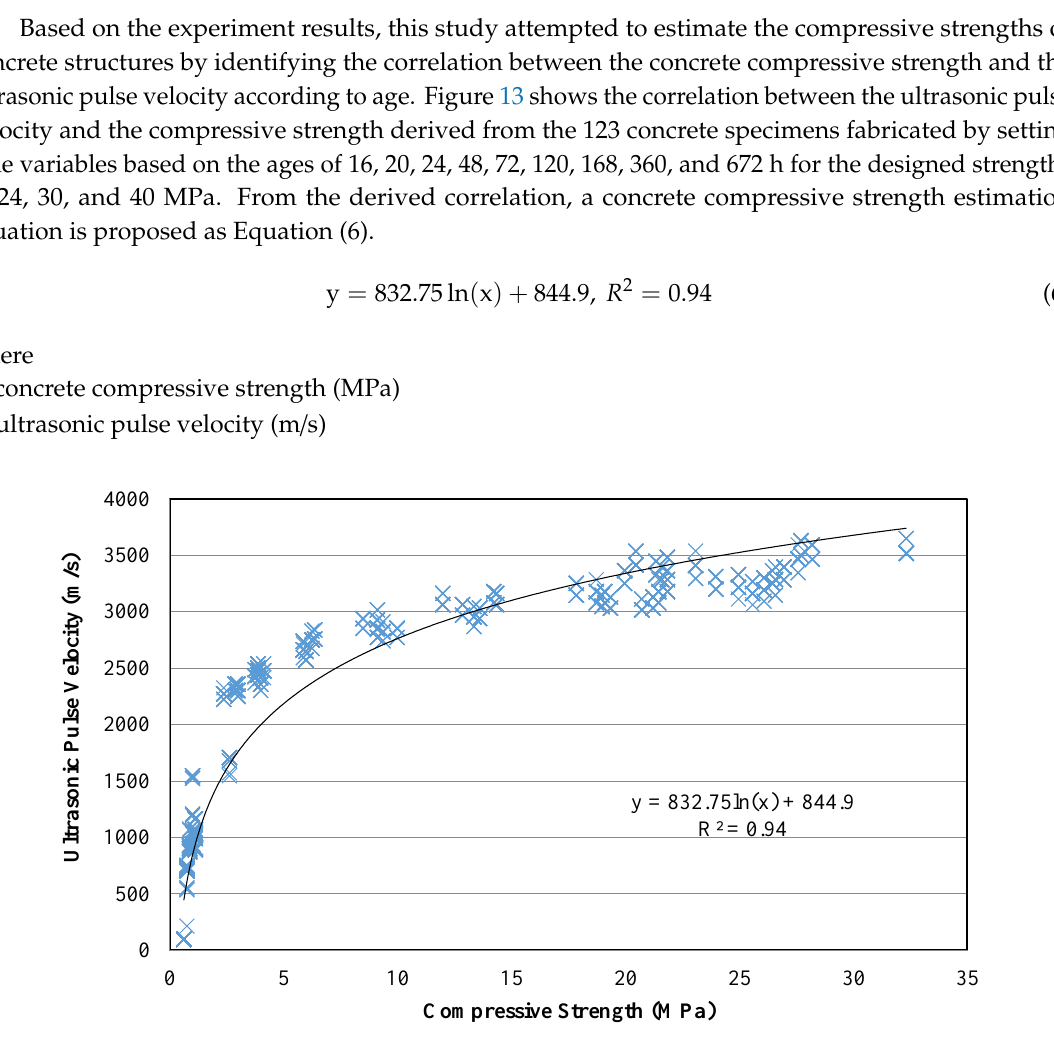
Figure 13. Estimation equation of compressive strength.